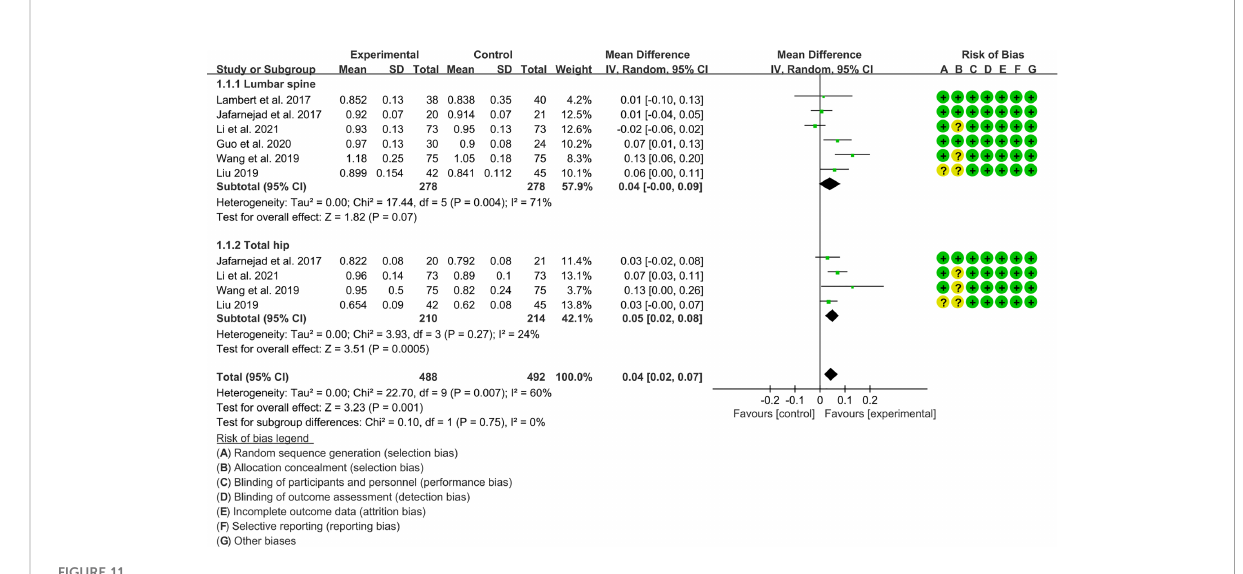
FIGURE 11 The absolute value of BMD (CI, con fi dence interval; SD, standard